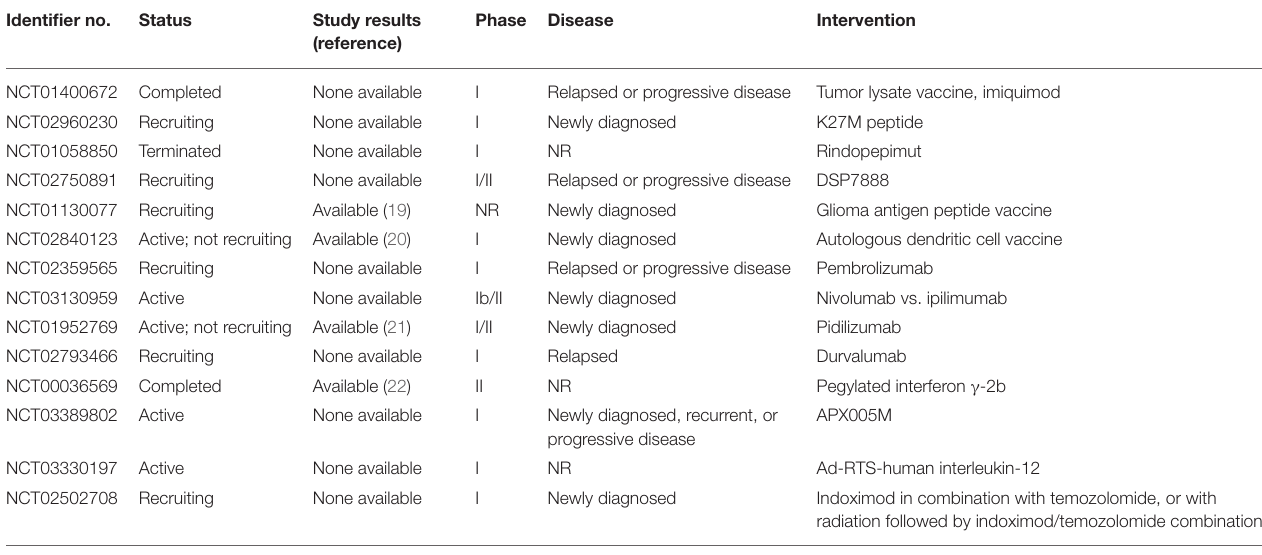
TABLE 1 | Clinical trials of immunotherapy in pediatric patients with diffuse intrinsic pontine/midline glioma registered at ClinicalTrials.gov as of December 2019. Identifier no.